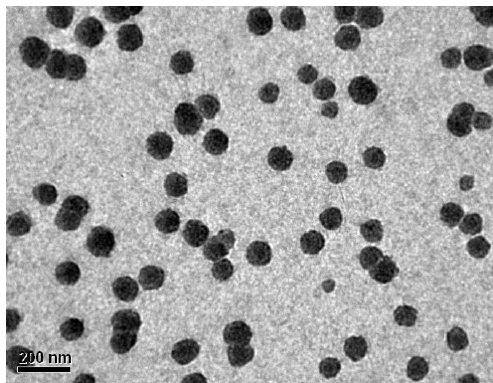
Figure 2. TEM image of nanoMIPs for octopamine.